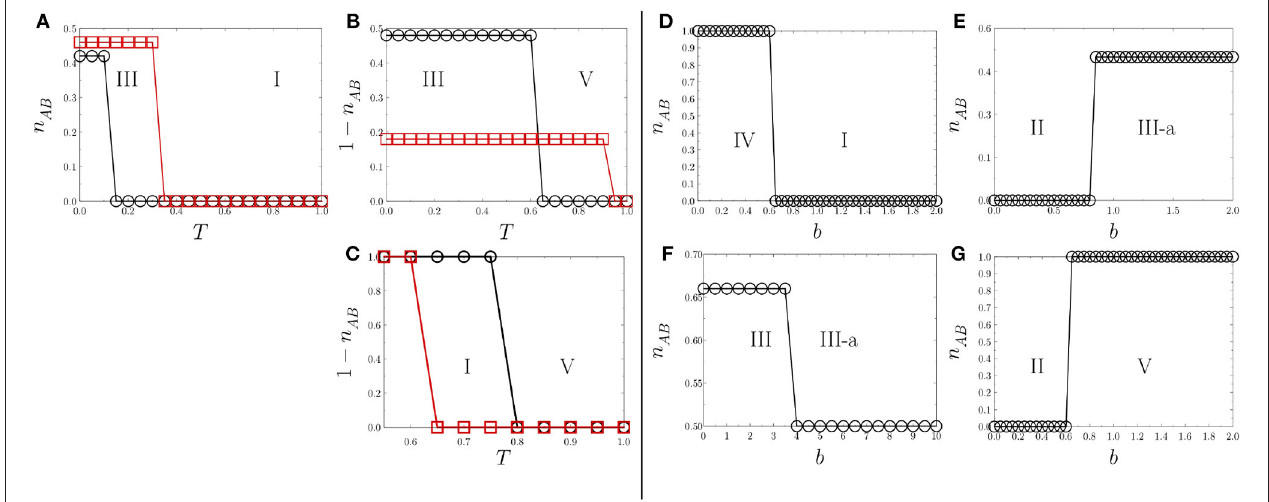
FIGURE 6 | Bifurcation diagrams for the average of n AB as function of T for fixed initial conditions for the SCG, (A–C) , and for the ACG, (D–G) . (A): x aa = 0.40 and x bb = 0.10 (circles), x aa = 0,40 and x bb = 0.30 (squares). (B): x aa = 0.40 and x bb = 0.60 (circles), x aa = 0,10 and x bb = 0.90 (squares). (C): x aa = 0.25 and x bb = 0.51 (circles), x aa = 0,37 and x bb = 0.52 (squares). (D): x aa = 0.30 and x bb = 0.45 with T = 0.75. (E): x aa = 0.10 and x bb = 0.48 with T = 0.15. (F): x aa = 0.25 and x bb = 0.1 with T = 0.7. (G): x aa = 0.45 and x bb = 0.65 with T = 0.75.